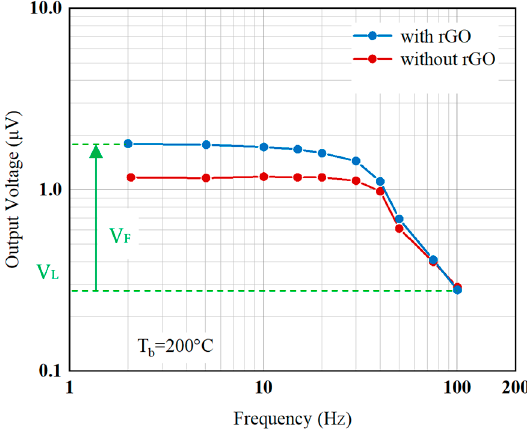
Figure 12. Frequency response of the thermopiles with and without rGO.